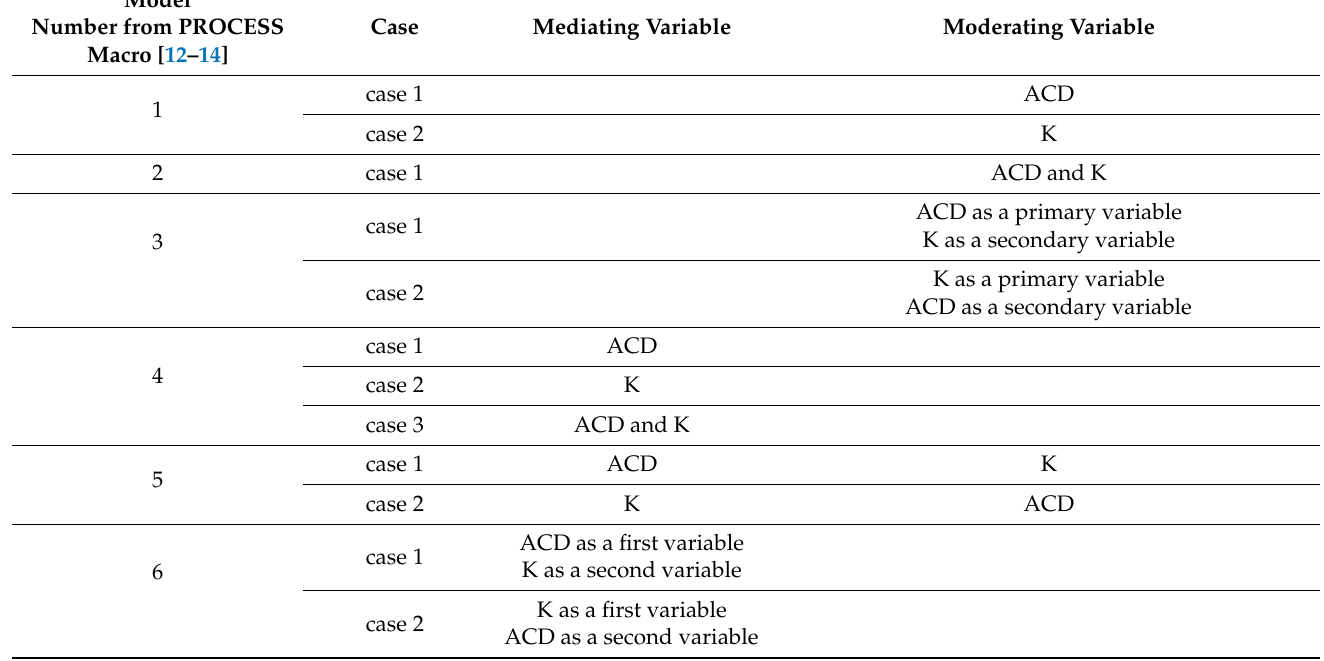
Table 1. Models with 3 variables for the prediction of effective lens position (ELP). The axial length (AL) was set as an independent variable and ELP was set as a dependent variable. Each model was provided by PROCESS macro for conditional process analysis